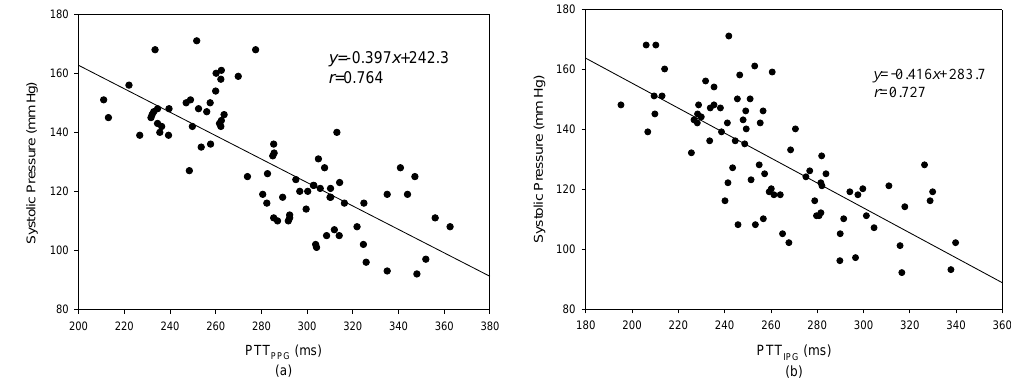
Figure 10. The result of the PTT PPG and systolic pressure. ( a ) The relation between the PTT PPG and systolic pressure, r = 0.764; ( b ) The relation between the PTT IPG and systolic pressure, r = 0.727.